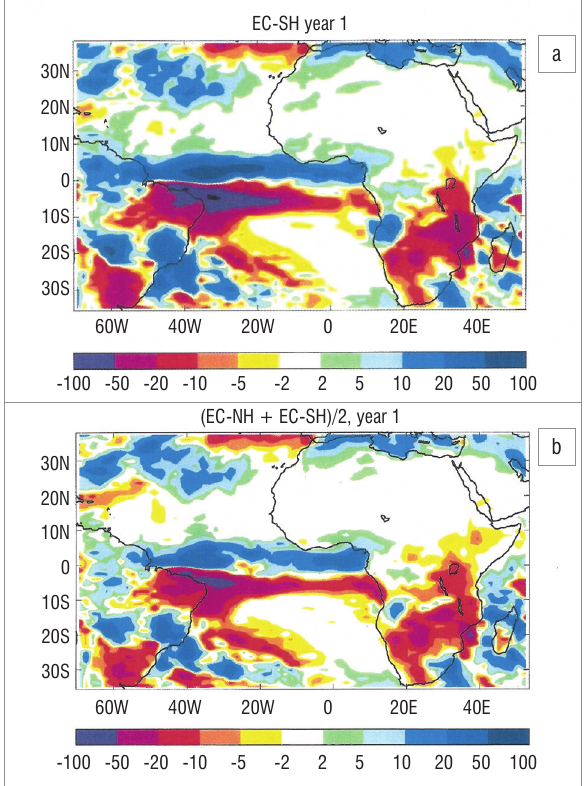
Figure 5: Model results from HadGEM for 1 year following an El Chichon- scale eruption for (a) injection of the aerosol load into the southern hemisphere and (b) injection of the aerosol load into both hemispheres, showing the per cent of induced change in annual precipitation along the lower colour-coded